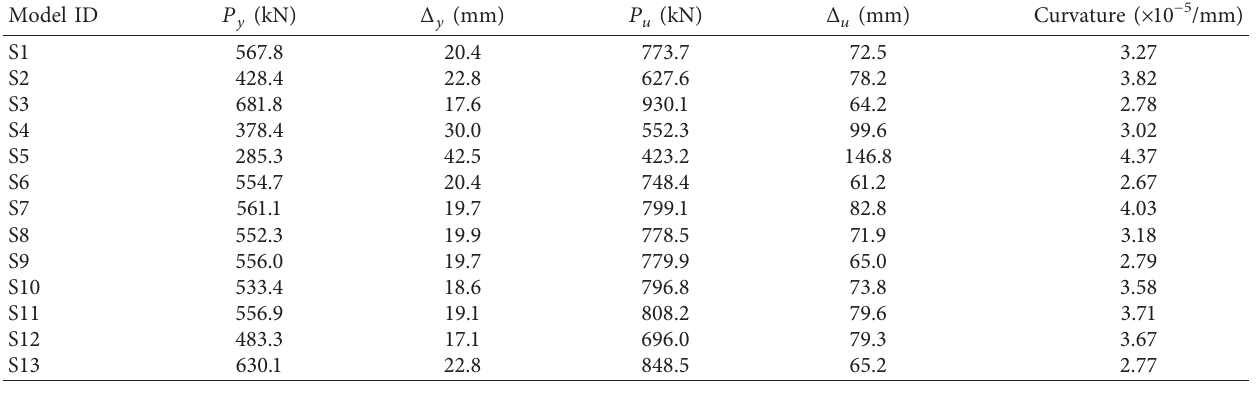
Table 3: Primary numerical results.